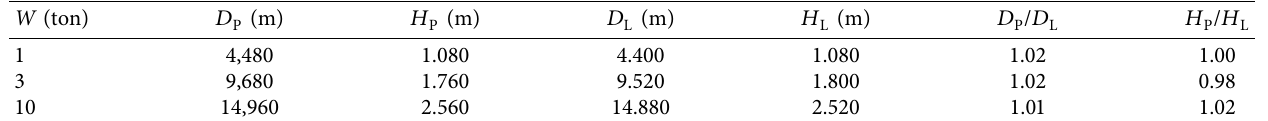
Table 7: Crater dimensions according to the initiation detonation